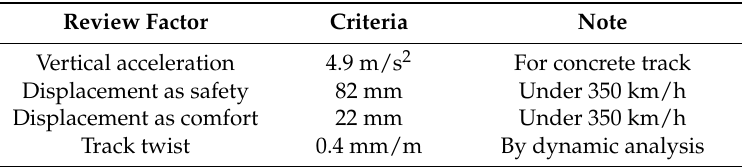
Figure 1. Kaya bridge ( a ) view and ( b ) cross section ( dimensions in mm ). Table 1. Railway Bridge design criteria [5].